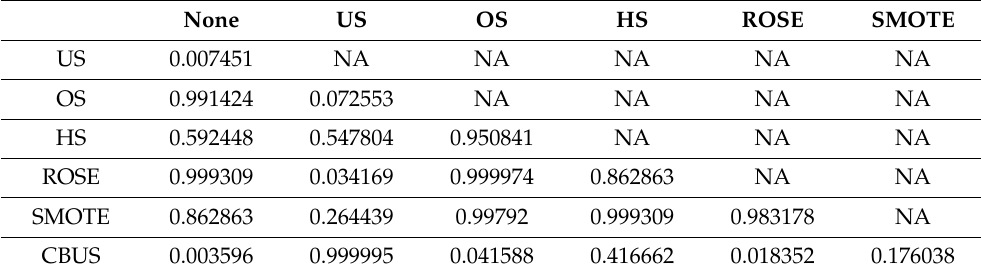
Table 12. Post hoc analysis using Nemenyi multiple comparison test for RF.